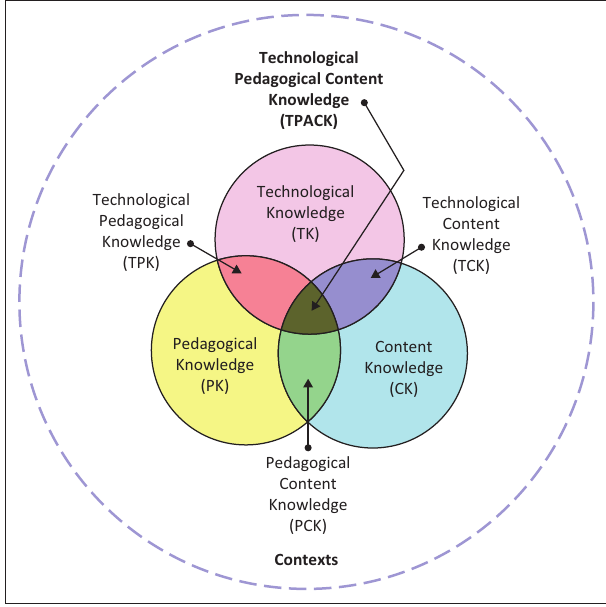
FIGURE 1: Technological pedagogical content